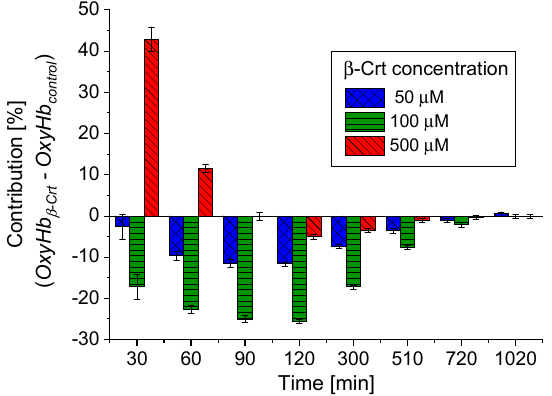
Figure 4. Comparison of time-dependent changes in OxyHb contributions in RBCs treated with different β -Crt concentrations, with respect to corresponding controls. The data is derived from Mössbauer spectra collected during certain time periods. Characteristic periods were selected to best visualise the differences in the variability of OxyHb β -Crt —OxyHb control for the β -Crt concentrations indicated. Average square errors are shown.